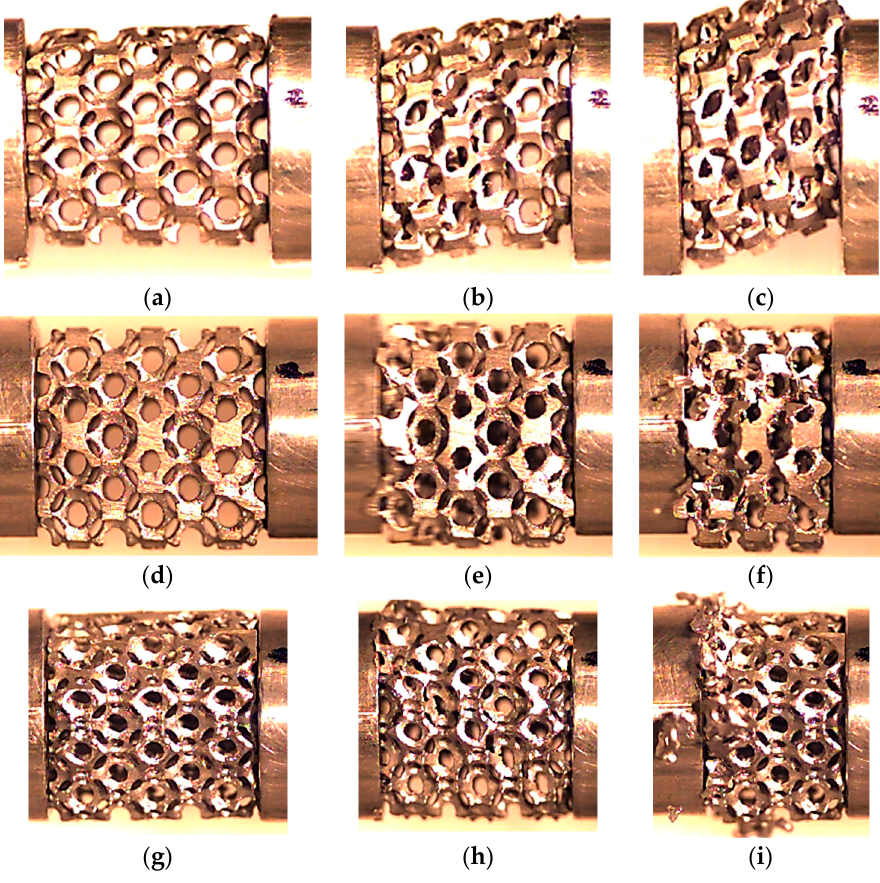
Figure 5. Failure modes for: ( a ) US20%-Al6082-T4 foams: initial; ( b ) US20%-Al6082-T4 foams: middle; ( c ) US20%-Al6082-T4 foams: end; ( d ) US20%-AlSi12 foams: initial; ( e ) US20%-AlSi12 foams: middle; ( f ) US20%-AlSi12 foams: end; ( g ) DS20%-AlSi12: initial; ( h ) DS20%-AlSi12: middle; ( i ) DS20%-AlSi12: